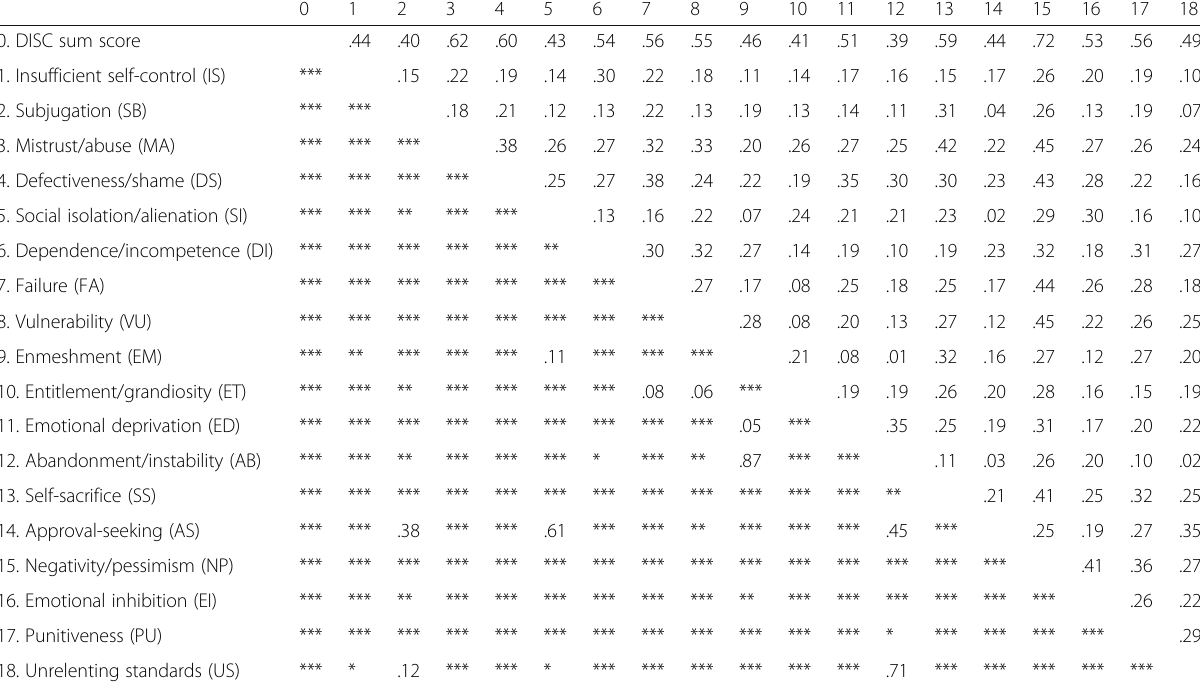
Table 4 Intercorrelations between the DISC ’ s overall sum score and the sum scores on schema level ( N = 569). According significance levels ( p values) are indicated in the lower triangular part of the matrix